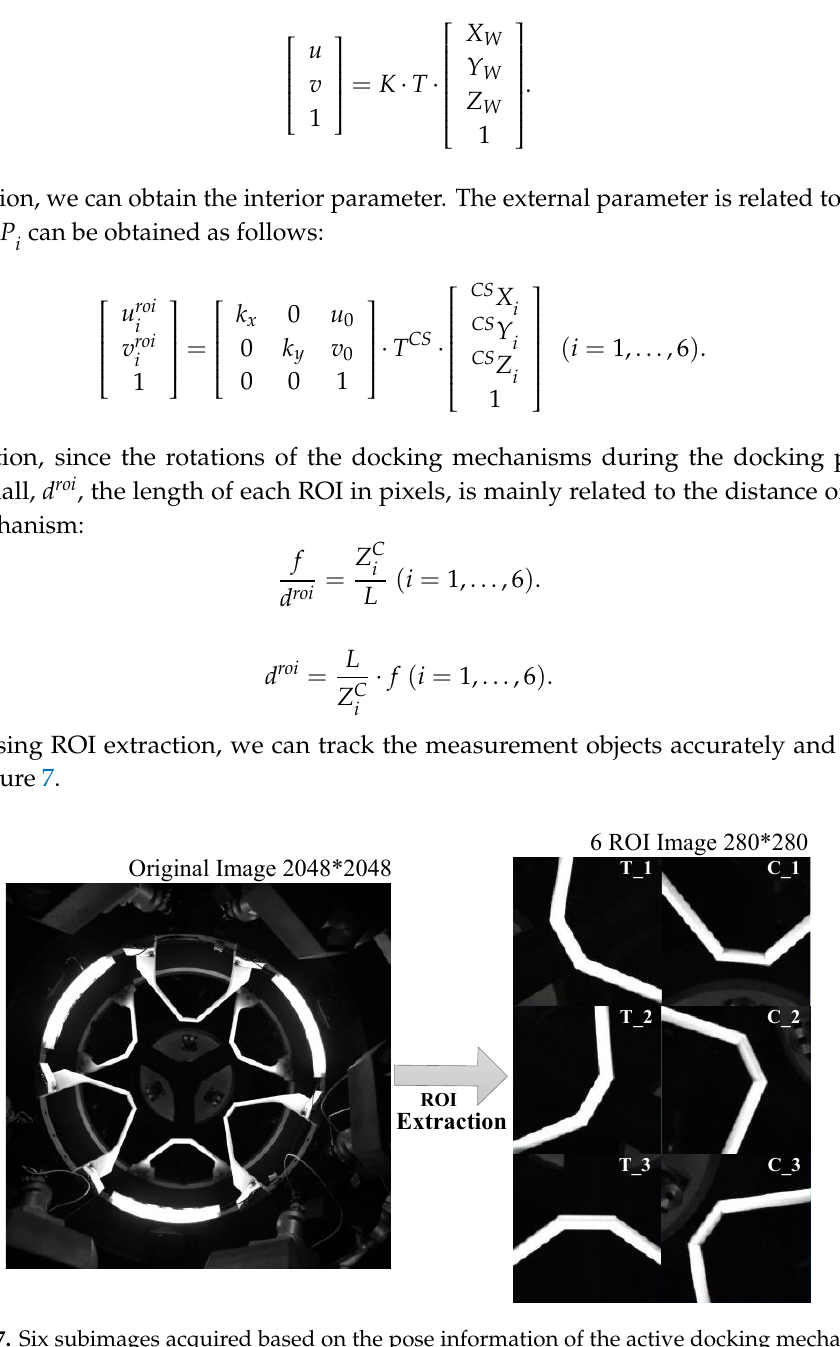
Figure 7. Six subimages acquired based on the pose information of the active docking mechanism.